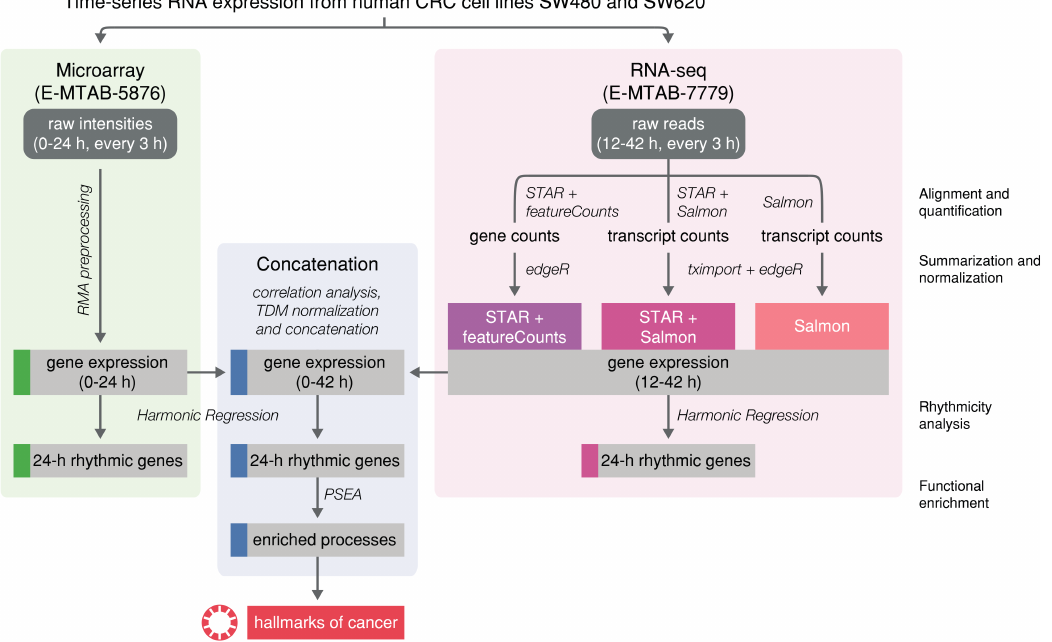
Figure 1. Workflow for the comparison of time-series microarray and RNA-seq data from human colorectal cancer (CRC) cell lines. Two circadian datasets (microarray and RNA-seq) for the cell lines SW480 and SW620 were pre-processed to determine gene expression values. For the RNA-seq data, three di ff erent methods ( STAR + featureCounts , STAR + Salmon , Salmon ) for the alignment and quantification of reads were applied to determine gene expression values. A correlation analysis for shared time points revealed which RNA-seq pre-processing method yields expression values that correlate best with the microarray expression. The best-correlated RNA-seq expression dataset was then TDM-transformed to the range of the microarray data and both datasets were concatenated to gain a longer time-series. 24 h rhythmic gene sets were determined based on the three di ff erent sets of data (microarray, RNA-seq and concatenated). Biological pathways enriched for the 24 h rhythmic genes of the concatenated dataset were determined and investigated with view to hallmarks of